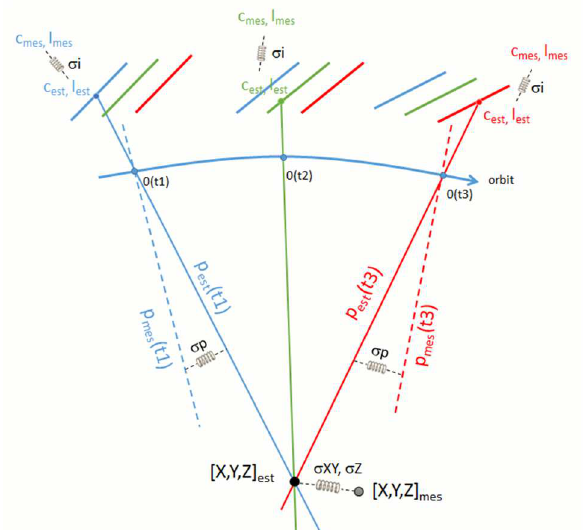
Figure 5 Principle of space triangulation applied to a single multiband pushbroom acquisition. Given measured image tie points and GCPs acquired in different bands at different times and attitude parameters p mes (t), we estimate a new set of image - ground coordinates and attitude parameters p est (t) that are consistent with collinearity equation and measurements error s p, s i, s XY, s